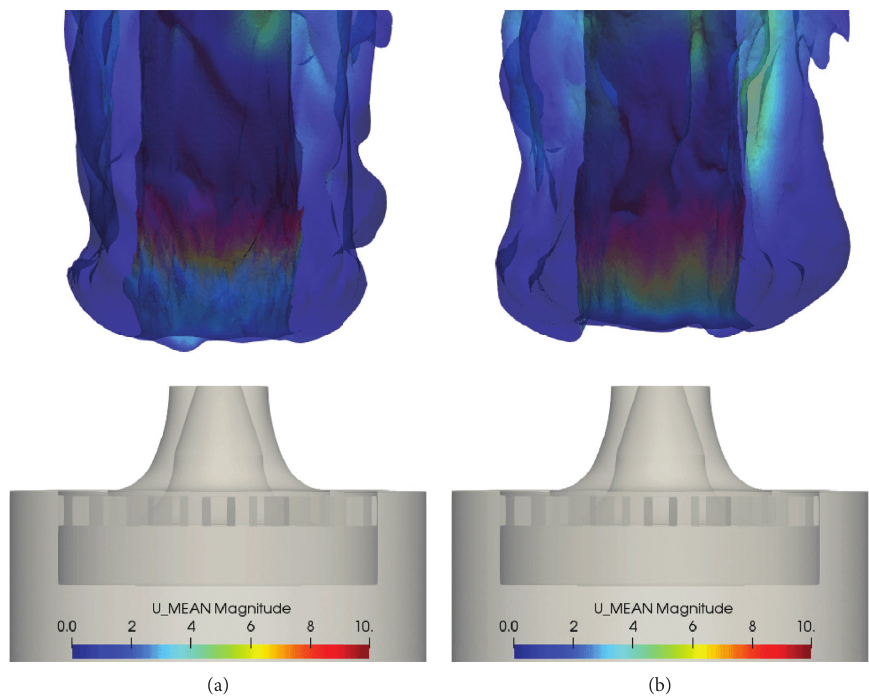
Figure 16: Contour of mean temperature T